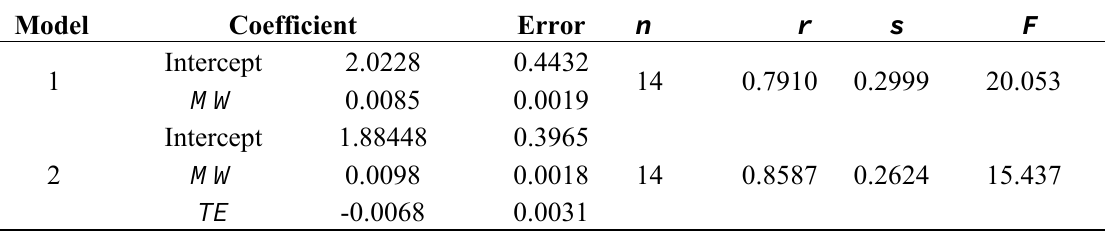
Table 4. Best MLR models for the prediction of antibacterial